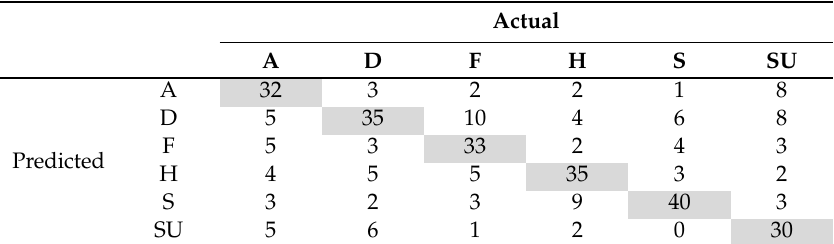
Table 9. Confusion matrix of the NC group using the H 1 feature in PNN classification.